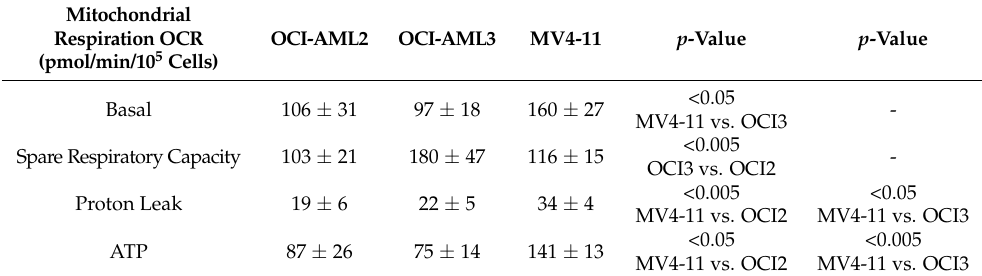
Table 5. Mitochondrial respiration values in AML cell